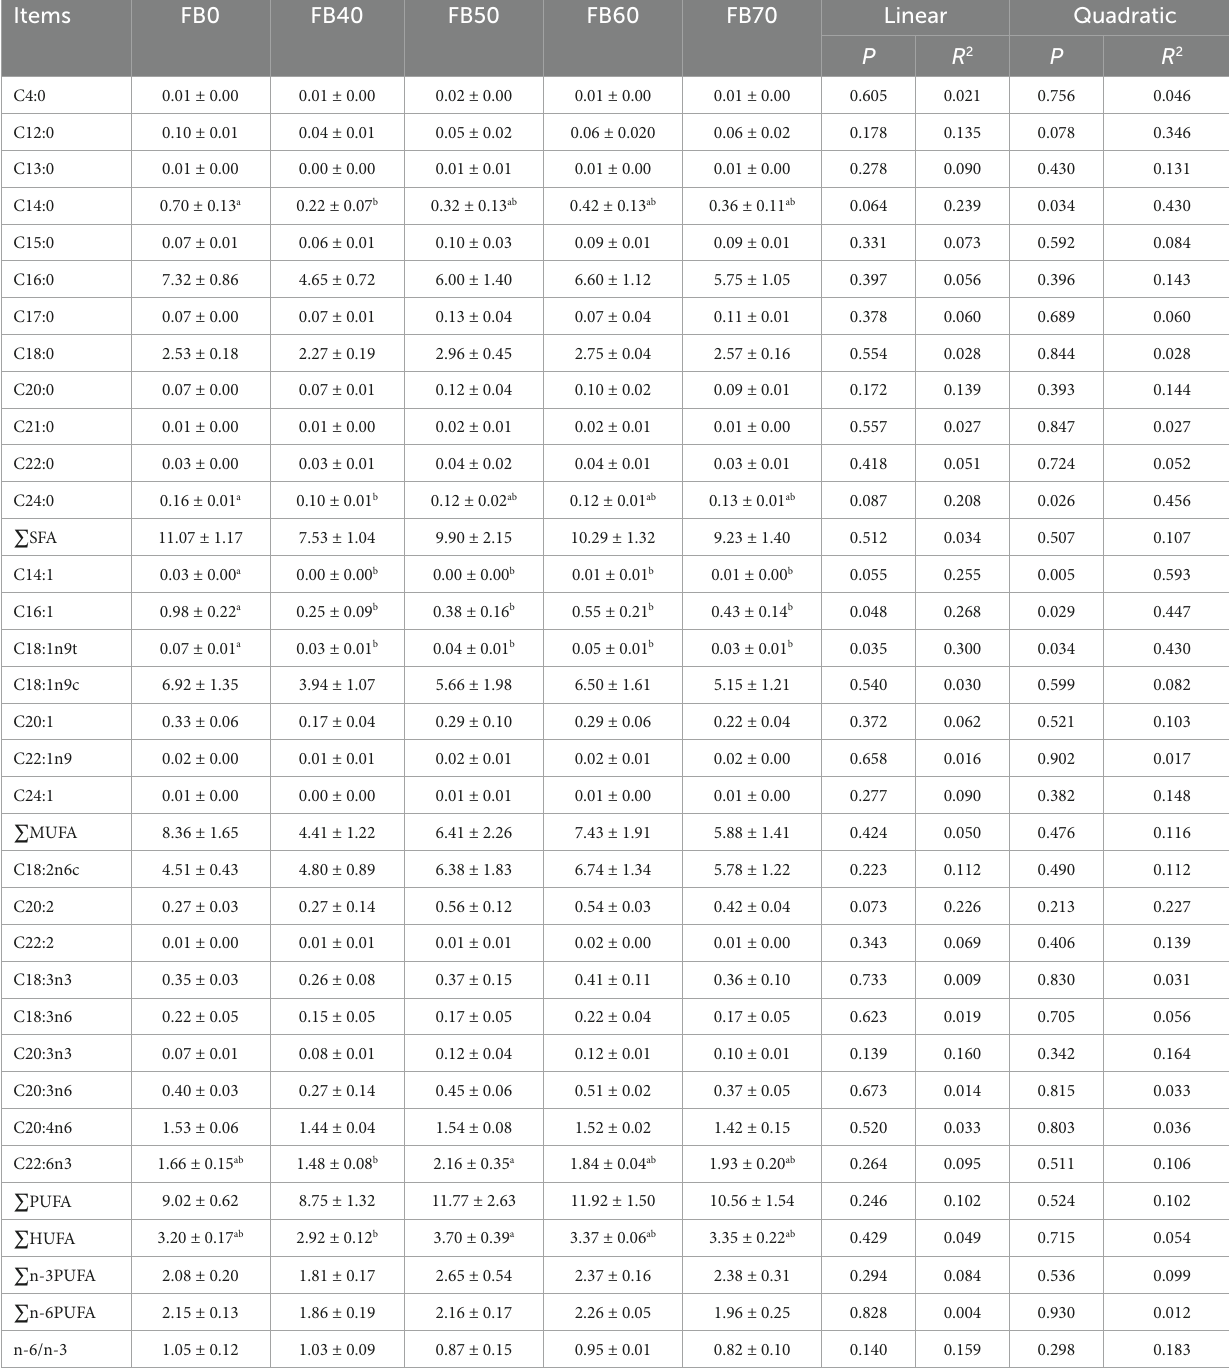
TABLE 5 Effects of dietary broad bean levels on fatty acid composition (mg/g dry weight) in muscle of tilapia Oreochromis niloticus. Items FB0 FB40 FB50 FB60 FB70 Linear